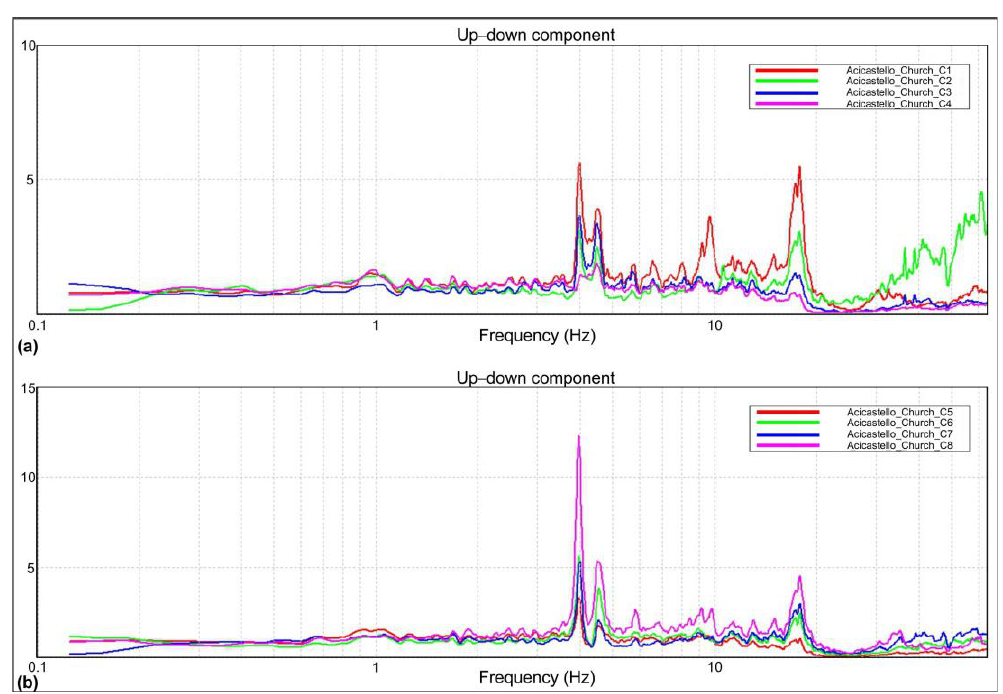
Figure 11. Averaged spectral ratios for Vertical n. 1 ( a ) and Vertical n. 2 ( b ) (Z direction). The tower ’ s modal vibration frequencies can be identified as those at which the max- imum amplitude of the SSR curve in the specific direction occurs on both verticals. Further peaks in the same direction for both vertical 1 and vertical 2 represent higher modes in that direction.